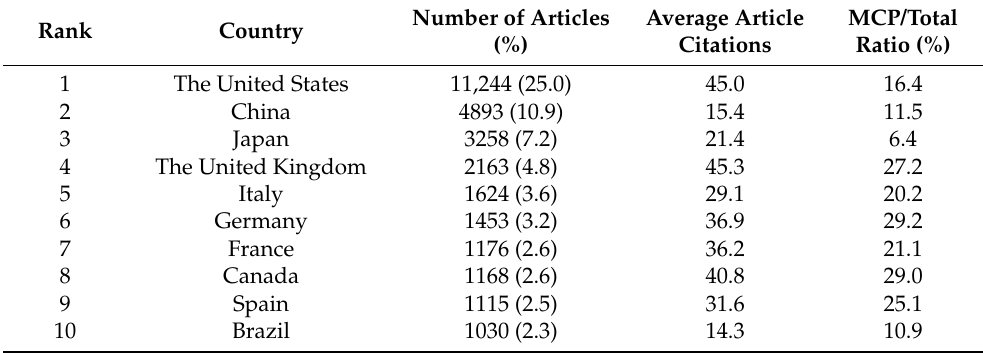
Table 2. The top 10 most productive countries, based on the affiliation of the corresponding author of original articles on systemic lupus erythematosus from 1971 to